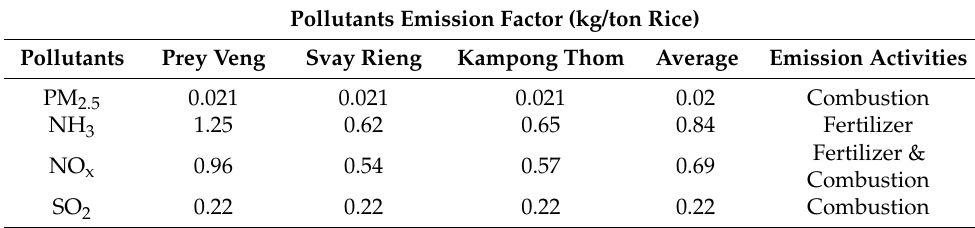
Table 3. Pollutants emitted in rice production per data from the